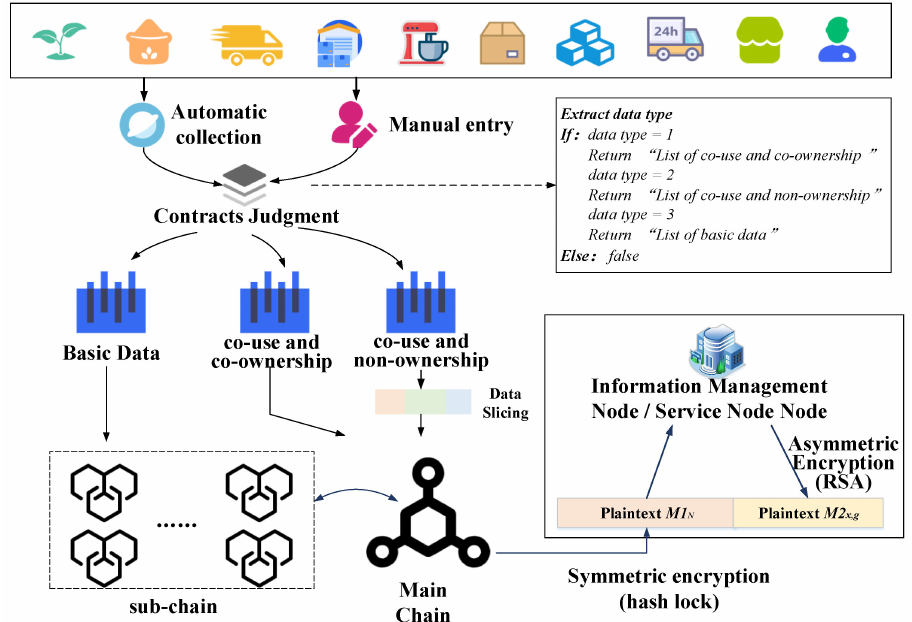
Figure 2. Schematic diagram of multi-party hybrid